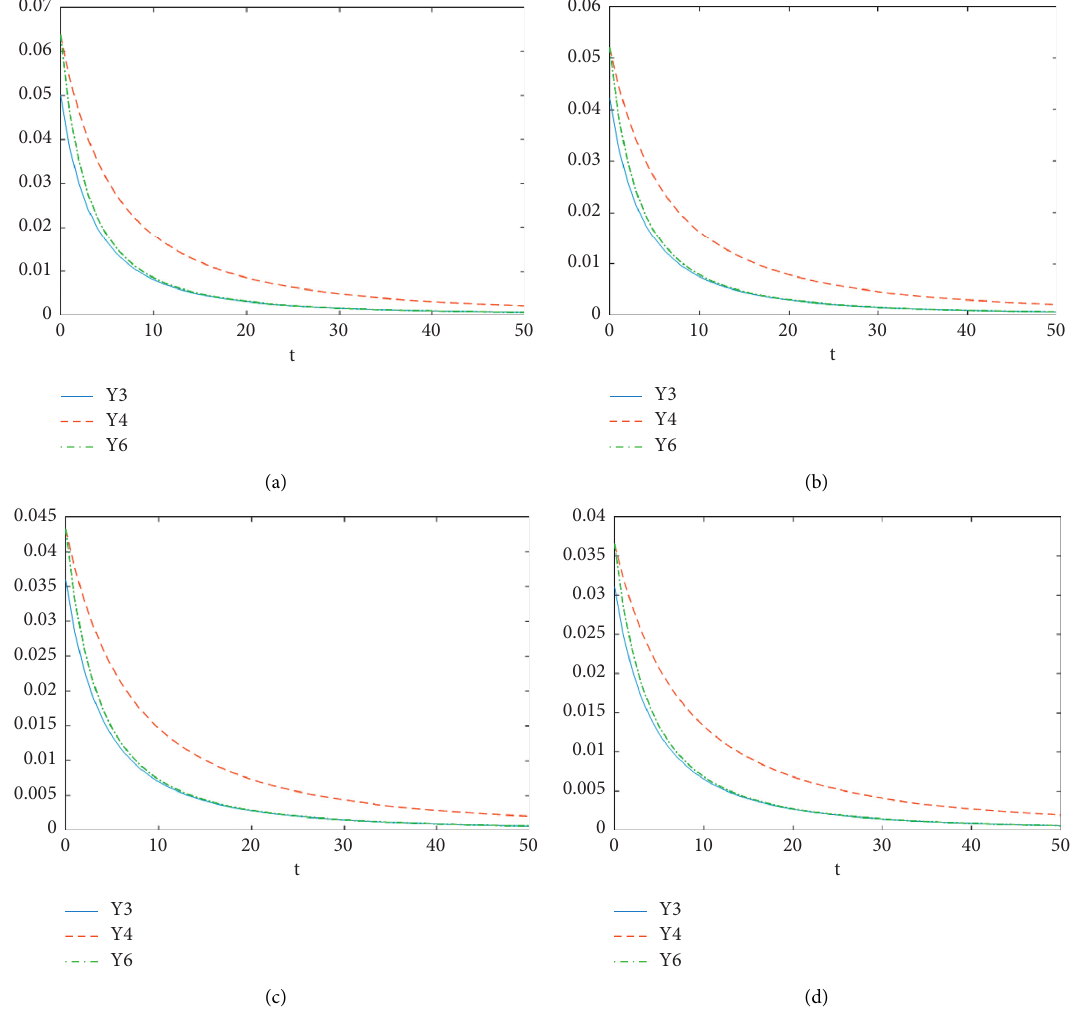
Figure 6: Balanced carbon emissions before and after the integration of Situation III and Situation IV ( s β � 0 . 4. (c) β � 0 . 6. (d) β � 0 .